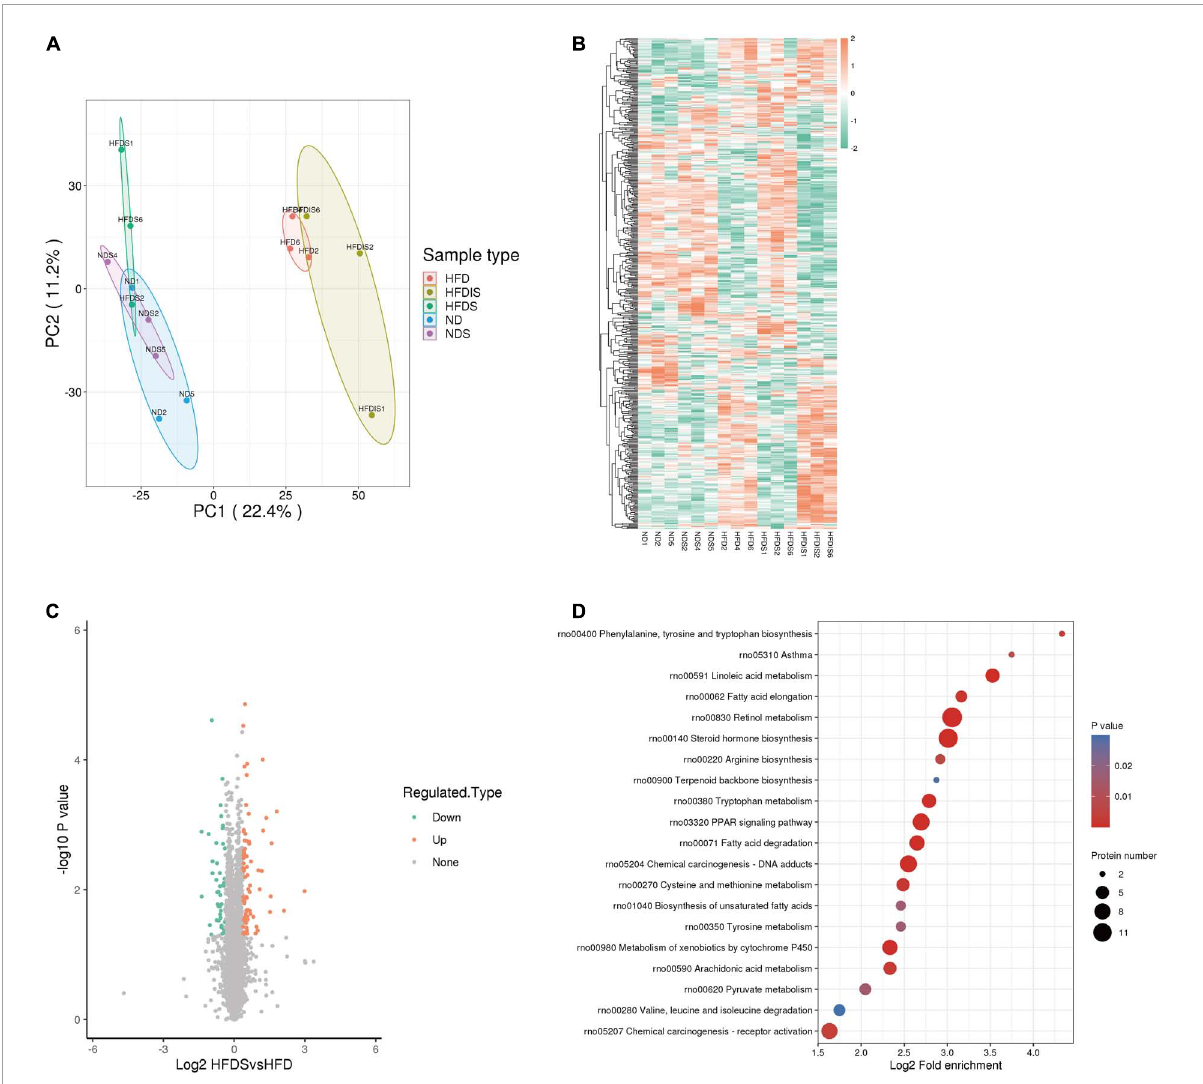
FIGURE3 Differentially expressed proteins (DEPs) were identified and analyzed using proteomics in the liver of HFD-Fed rats. (A) Results of quantitative protein principal component analysis (PCA) of all liver samples. (B) Cluster chart of DEPs. Red and green represent significant upward and downward adjustments, respectively. (C) Volcano map for the HFDS vs. HFD group. The red and green dots represent significantly up- and down-regulated differential proteins, respectively. The black dots represent proteins that showed no difference. (D) Bubble plot of the top 20 KEGG enrichment pathways of DEPs. Fold enrichment is the Log2-transformed value of the fold change in the proportion of differentially expressed proteins in that functional type compared to the proportion of identified proteins.